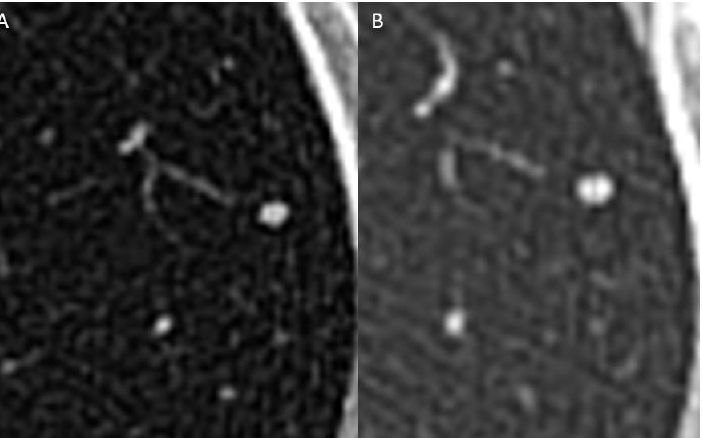
Figure 2. Magnified images from 0.625 mm slice non-contrast Computed Tomography (CT) scan at baseline ( A ) and contrast-enhanced CT 2 months later ( B ) show a 3 mm pulmonary nodule in the left upper lobe with possible calcification on the later study.